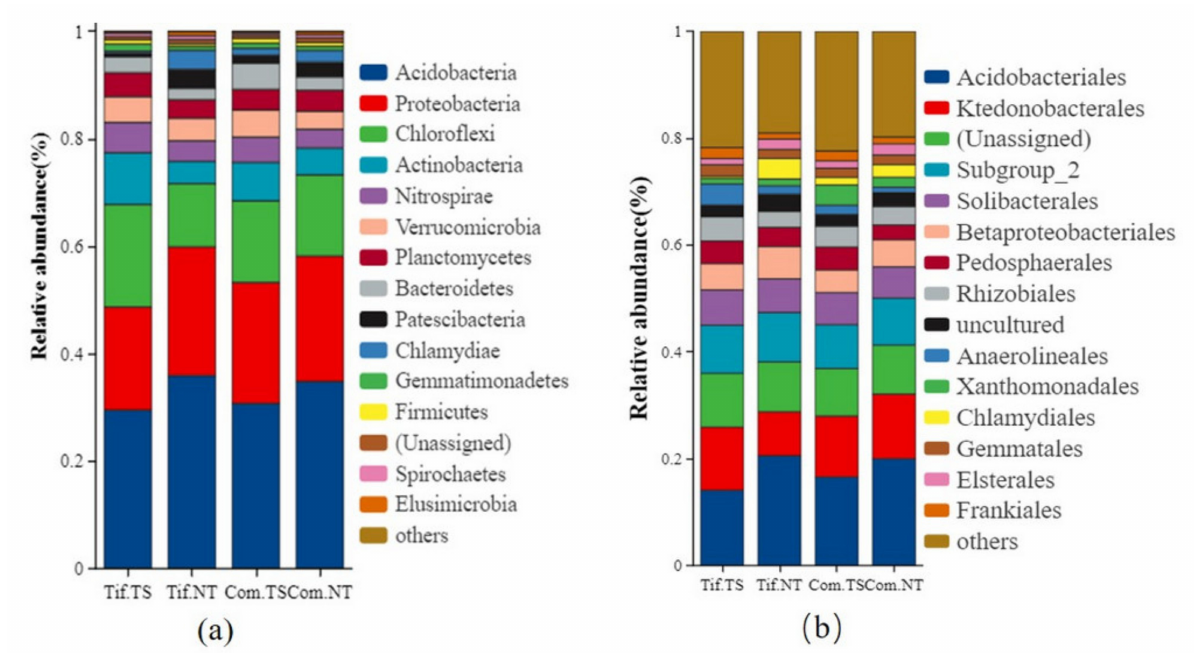
Figure 4. Difference in bacterial community relative abundances at phylum ( a ) and order ( b ) levels. Note: Tif.TS, Tifgreen bermudagrass with traffic treatment; Tif.NT, Tifgreen bermudagrass with non-traffic treatment; Com.TS, Common bermudagrass with traffic treatment; Com.NT, Common bermudagrass with non-traffic